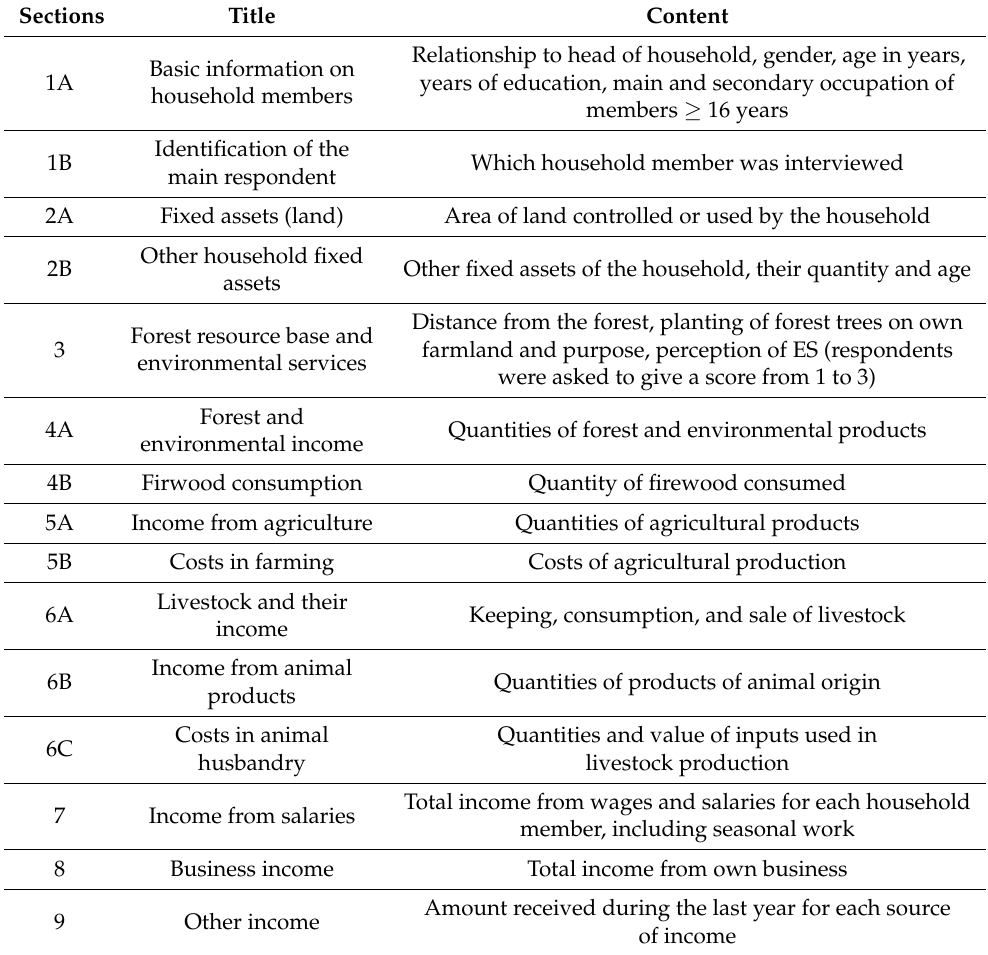
Table 1. Sections and content of the household questionnaire 1 (based on [54]).